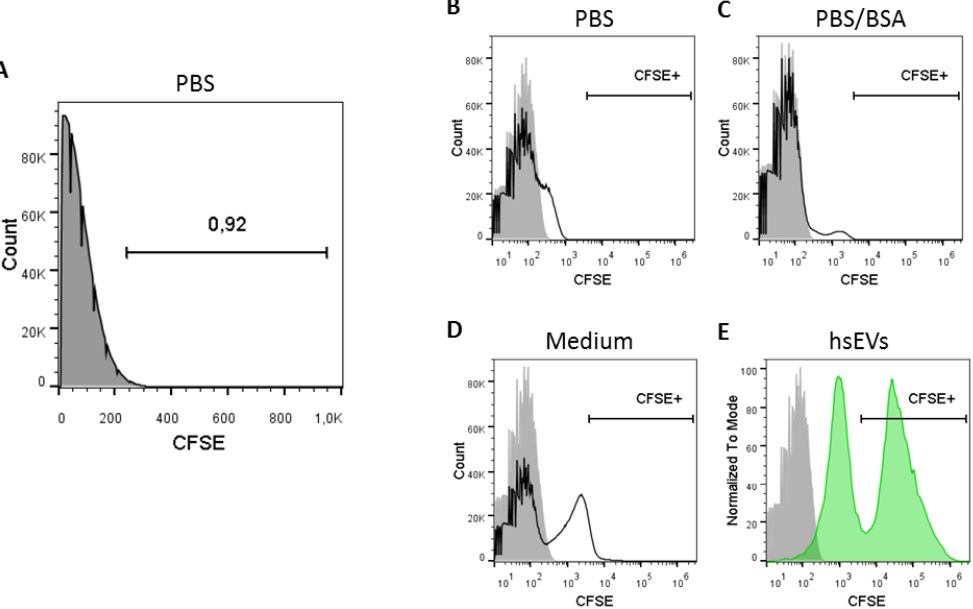
Figure 3. Selection of the appropriate sample bu ff er for hsEV reconstitution. ( A ) PBS without EVs and CFSE dye was measured to determine background noise. Events detected in the FITC channel are expressed in linear axis scaling format. Accordingly, a threshold of 250 in the FITC channel would exclude almost all events, since the gated area comprises less than 1%. We detected EV-independent signals over background noise when CFDA-SE was incubated in ( B ) PBS, ( C ) PBS / bovine serum albumin (BSA) or ( D ) cell culture medium. ( E ) The gate for detecting EV-dependent fluorescence signals in the FITC channel was set according to a CFSE-labeled hsEV sample. Samples were measured with a threshold of 0 for the FITC channel. Grey filled histogram = PBS without CFDA-SE; black line histogram = bu ff er with CFDA-SE; green filled histogram = CFSE-labeled hsEVs.